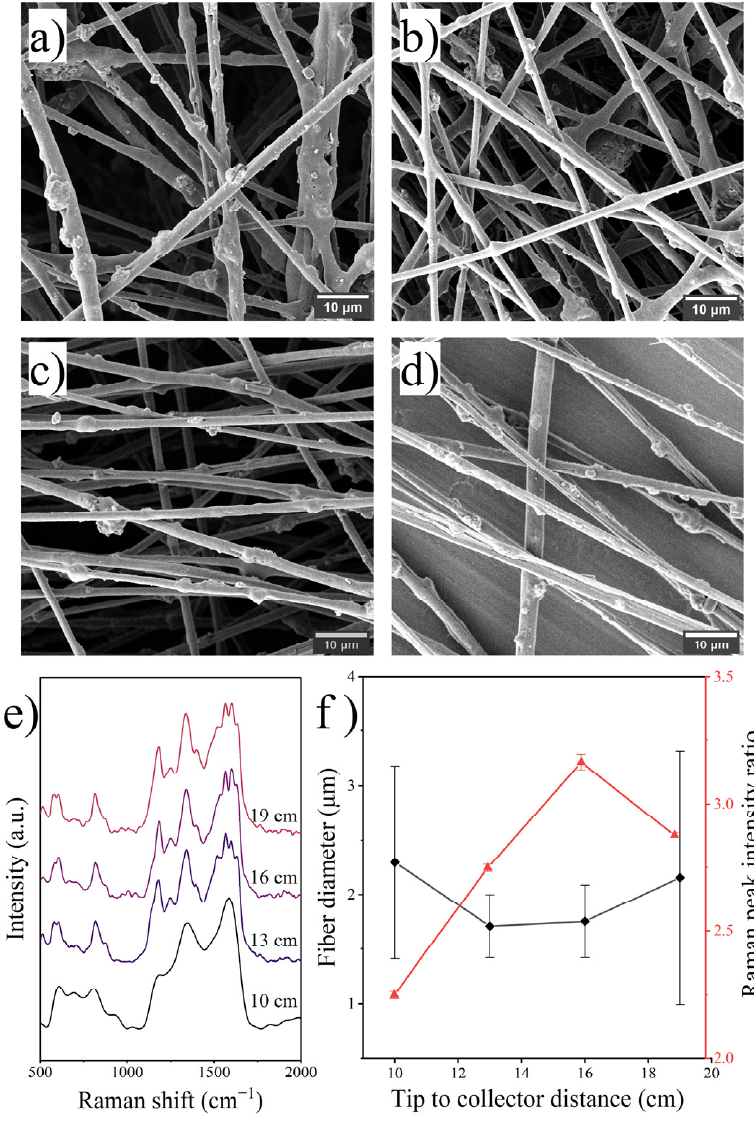
Figure 5. SEM images of fibers prepared with various TCD: ( a ) 10 cm, ( b ) 13 cm, ( c ) 16 cm, ( d ) 19 cm; ( e ) Raman spectra of the fibers and ( f ) effects of TCD on fiber diameter and surface PANI occu- pancy.